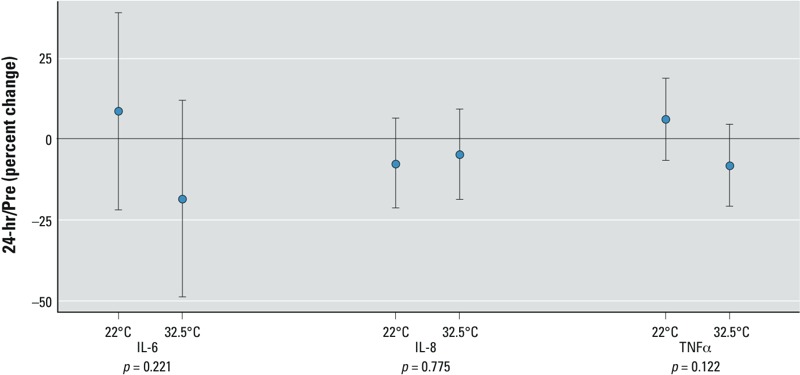
Markers of inflammation after 2 hr ozone exposure at 0.3 ppm, with effects for moderate (22°C) and high (32.5°C) temperatures; the effect of ozone on systemic inflammation markers on the late time point is shown. The mean (effect size) and 95% CIs for 16 subjects are shown. p-Values are for ozone–temperature interaction.